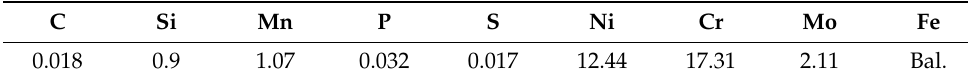
Table 1. Chemical composition of SUS316L gas-atomized powders (mass%).